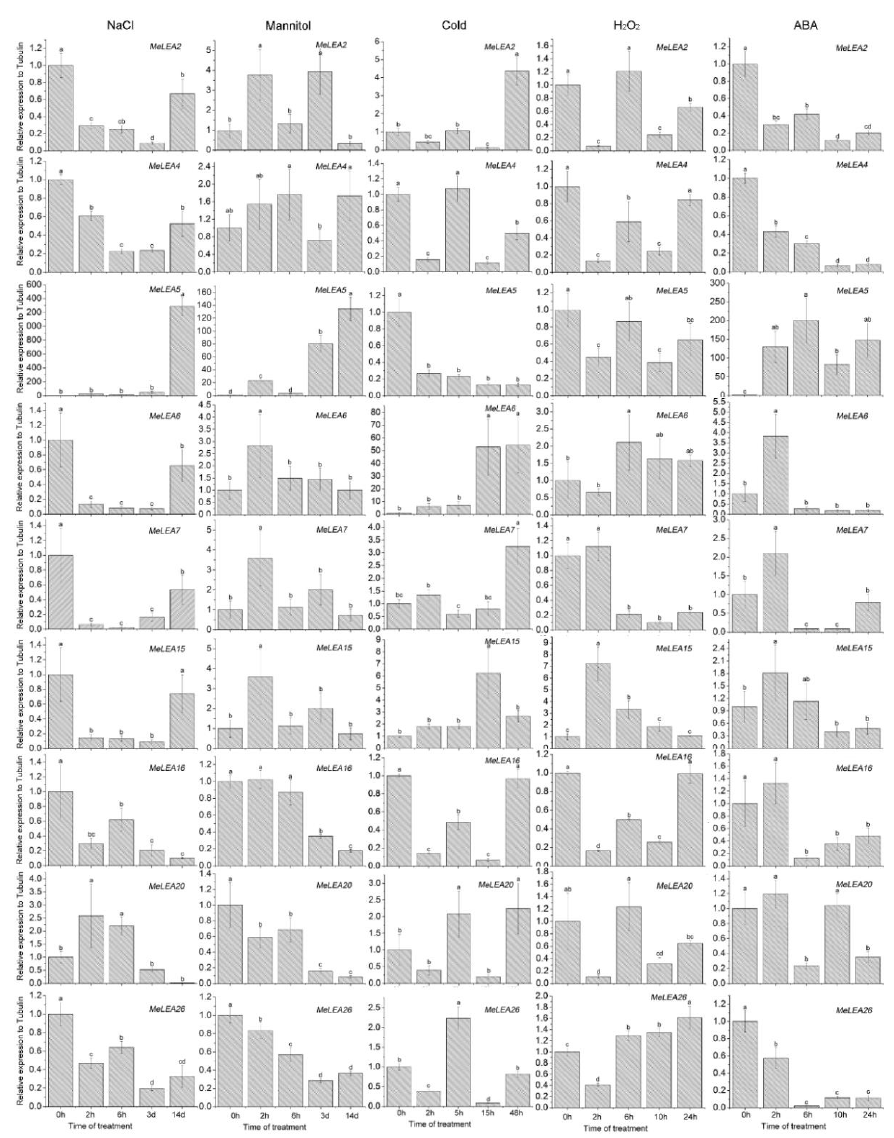
Figure 7. Expression profiles of the MeLEAs in leaves under salt, osmotic, cold, H 2 O 2 , and ABA treatments. NTC (no treatment control) was normalized as “1”. Data are means ± SD of n = 3 biological replicates. Means denoted by the same letter do not significantly differ at p < 0.05 as determined by Duncan’s multiple range